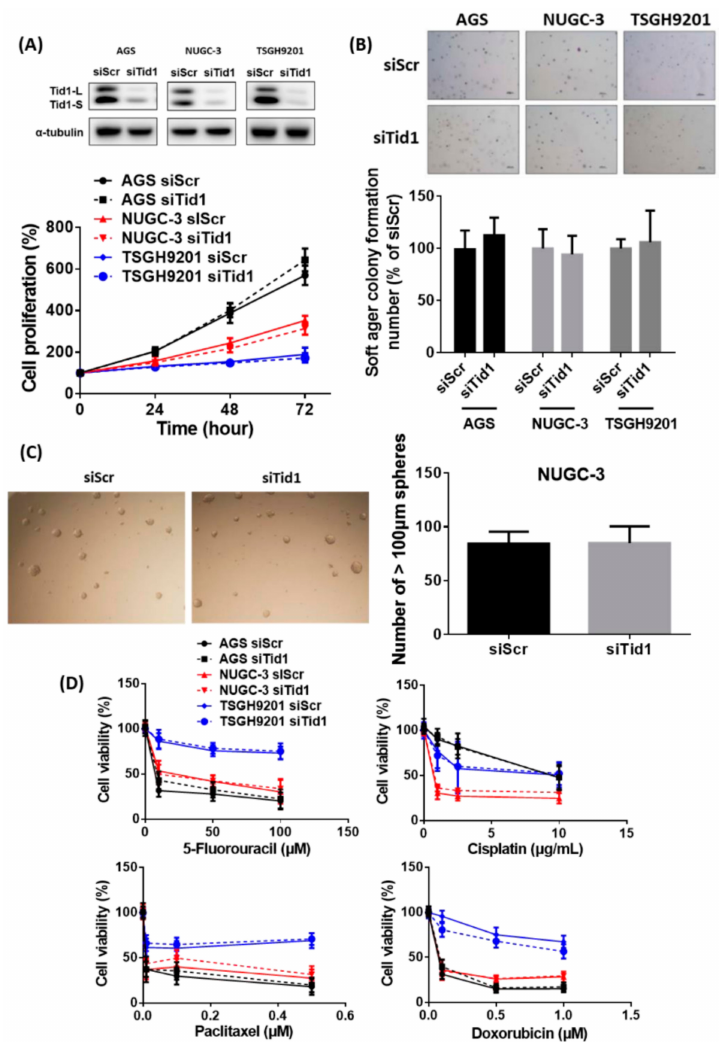
Figure 2. E ff ect of Tid1 knockdown on cell proliferation, colony formation, tumor sphere formation, and chemotherapy sensitivity of gastric cancer cells. ( A ) The e ff ect of Tid1 knockdown on cell proliferation was evaluated by the sulforhodamine B (SRB) assay. After knockdown of Tid1 by siRNA, the gastric cancer cells were reseeded and cell proliferation was evaluated for 3 days. ( B ) The e ff ect of Tid1 knockdown on colony formation was evaluated using a soft agar colony formation assay. After knockdown of Tid1 by siRNA, the gastric cancer cells were reseeded and colony formation was evaluated for 30 days. ( C ) The e ff ect of Tid1 knockdown on tumor sphere formation was evaluated using a tumor sphere formation assay. After knockdown of Tid1 by siRNA, the NUGC-3 gastric cancer cells were reseeded and sphere formation was evaluated for 10 days. ( D ) The chemotherapy sensitivity was evaluated using a SRB assay. After knockdown of Tid1 by siRNA, the gastric cancer cells were reseeded and treated with di ff erent chemotherapy agents for 2 days. The e ffi ciency of Tid1 knockdown was confirmed by Western blot. Data are presented as mean ± SD of at least three independent experiments. p < 0.05, compared with the siRNA for scramble (siScr) control